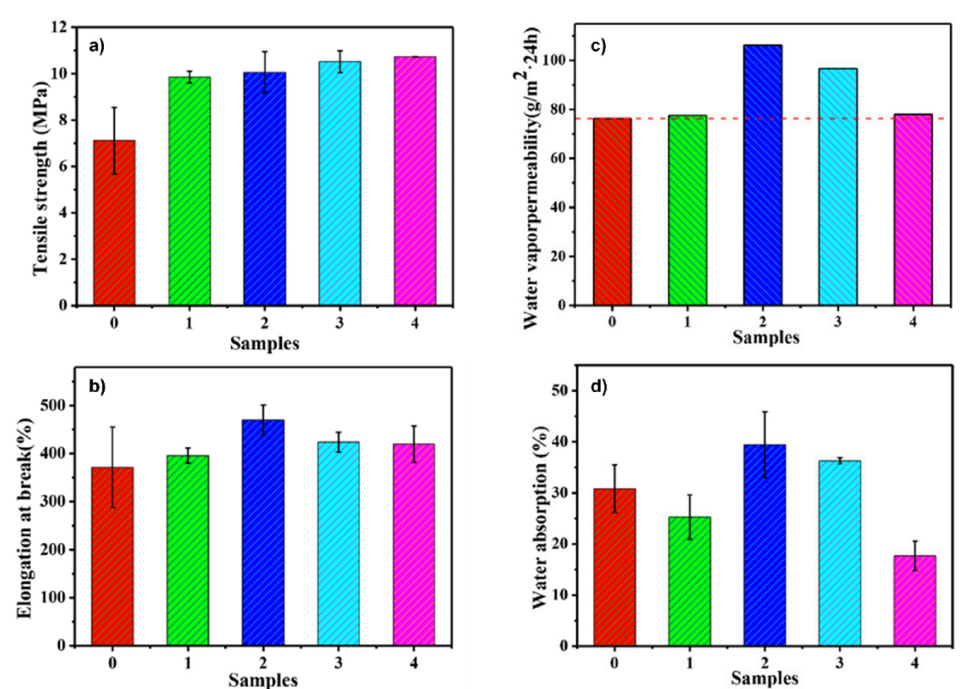
Figure 11. Effect of fillers on mechanical properties ( a ) Tensile strength, ( b ) Elongation at break, and on ( c ) water vapor permeability and ( d ) water resistance of composite films (0. PMA, 1. PMA/SiO 2 , 2. PMA/KH550-SiO 2 , 3. PMA/KH560-SiO 2 and 4. PMA/KH570-SiO 2 ). Adapted from Ref. [108].